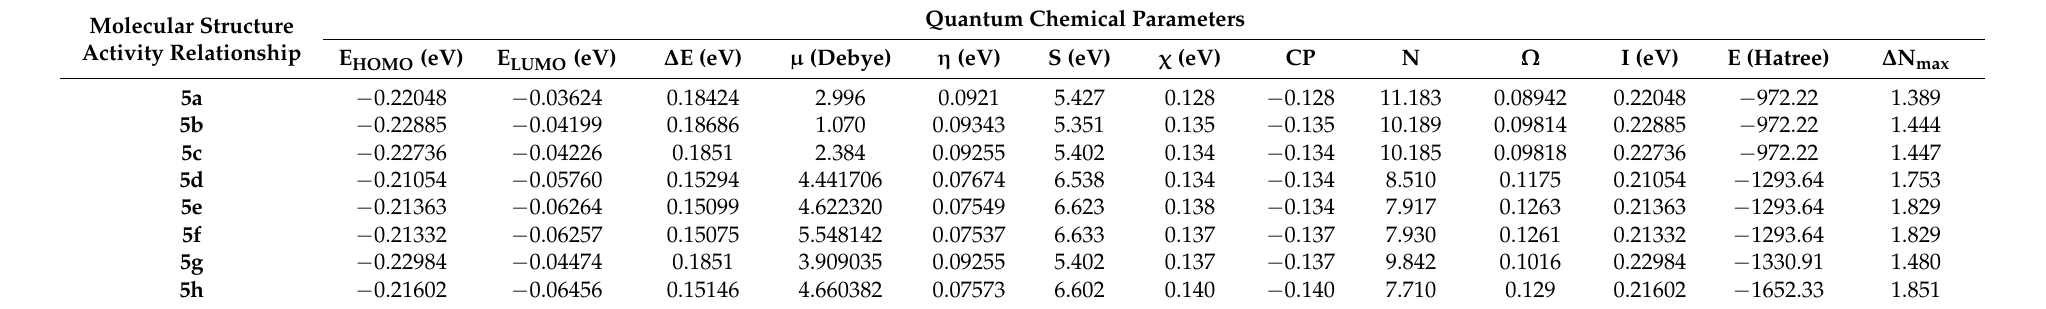
Table 3. Quantum and geometrical-based computational parameters based on DFT calculations having 321-G basis set to facilitate SAR studies of compounds, where EHOMO (eV), ELUMO (eV), Energy Gap “ ∆ E = ELUMO-EHOMO (eV)”, Dipole Moment “ µ (Debye)”, Global Hardness “ η (eV)”. Molecular